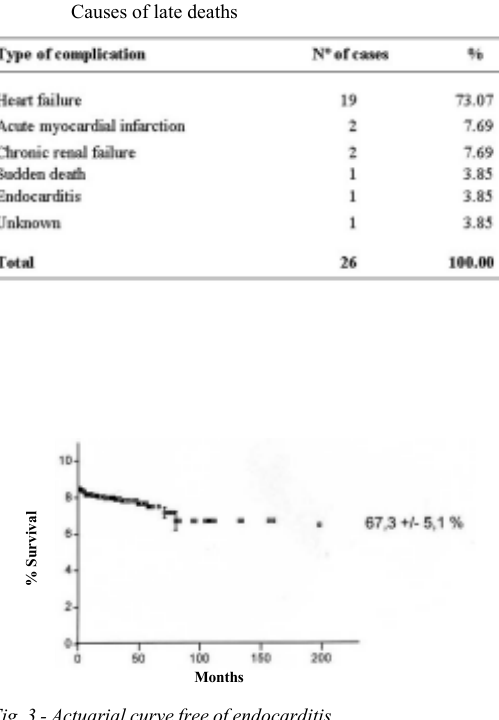
Fig. 3 - Actuarial curve free of endocarditis